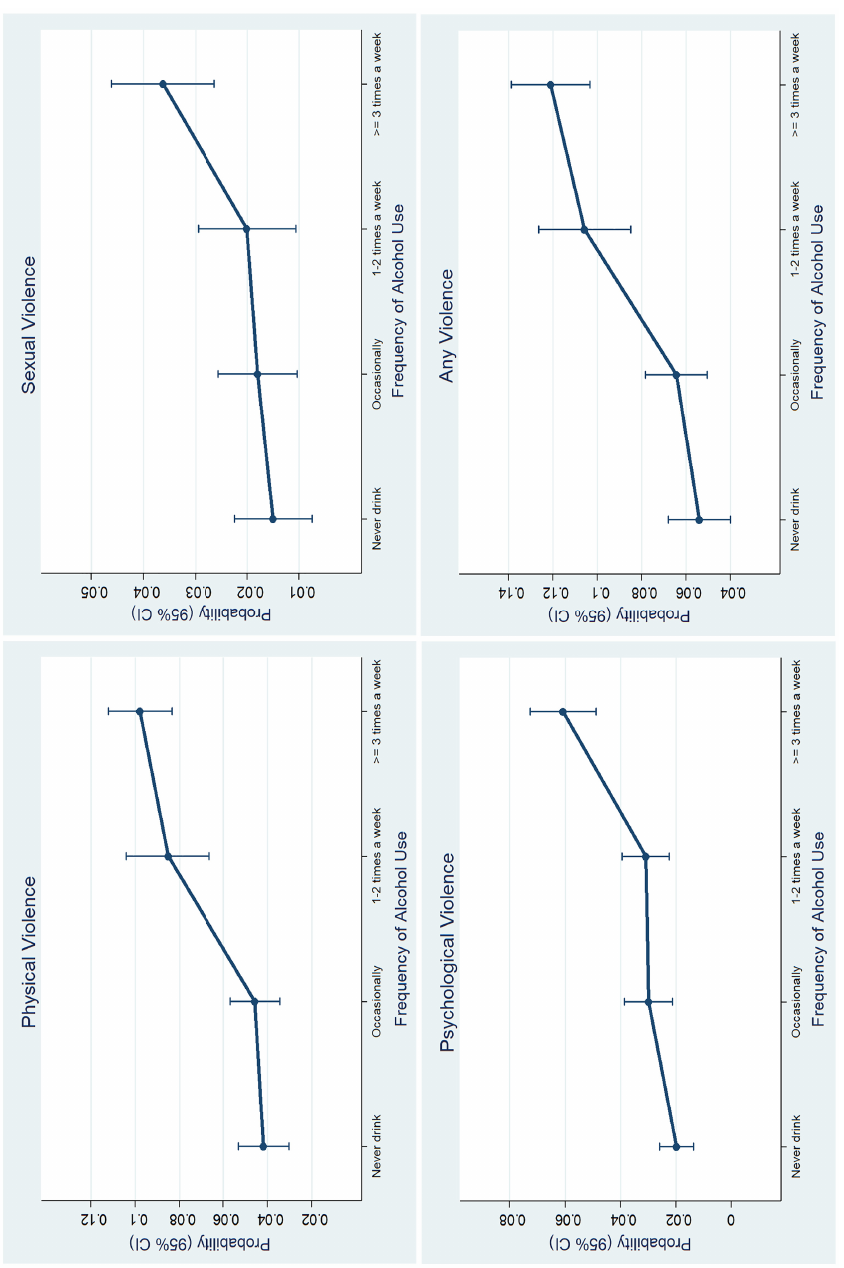
Figure 1. Margin probabilities of physical, sexual, psychological and any violence by frequency of alcohol